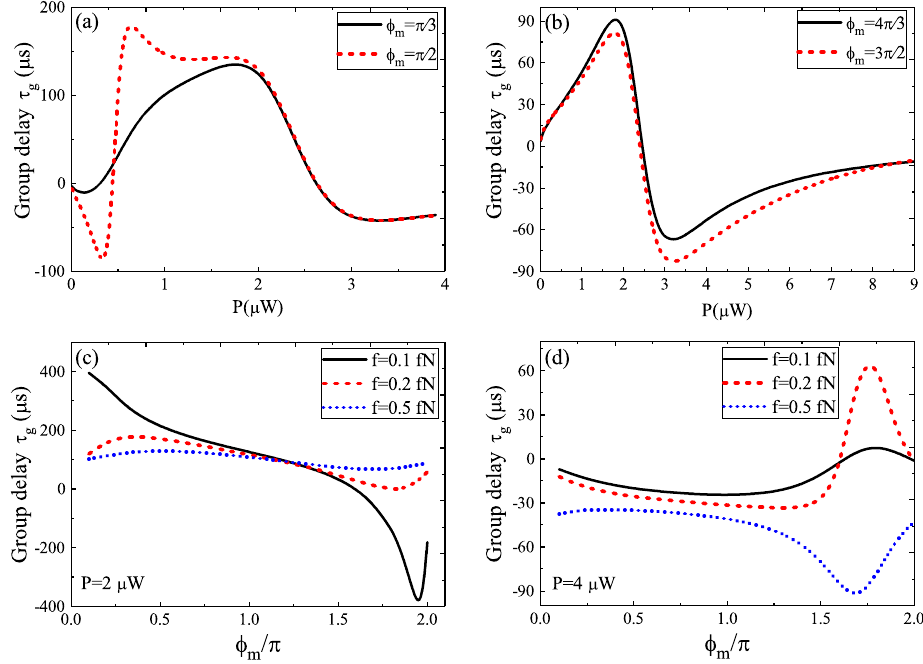
Figure 5. ( a ) The τ g as a function of P for ϕ m = π /3 and ϕ m = π /2. ( b ) The τ g as a function of P for ϕ m = 4 π /3 and ϕ m = 3 π /2. ( c ) The τ g as a function of ϕ m for three driving amplitudes f at P = 2 µ W. ( d ) The τ g as a function of ϕ m for three driving amplitudes f at P = 4 µ